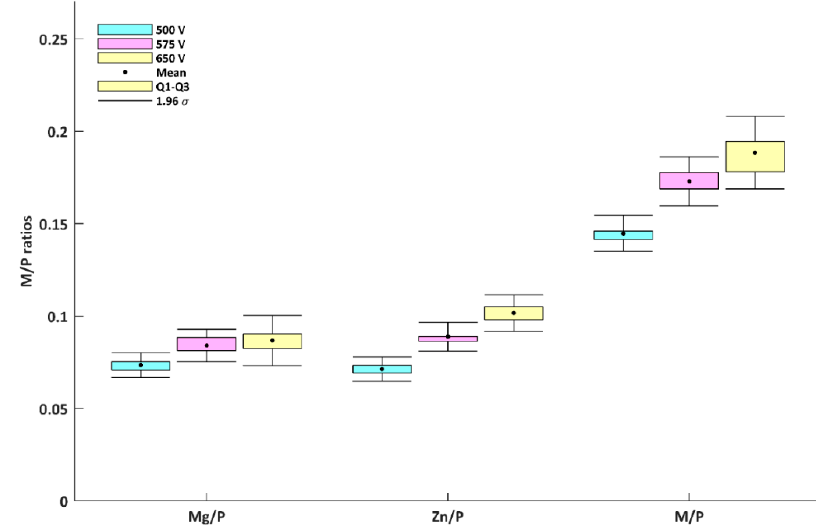
Figure 10. EDS results for samples after PEO processing obtained in electrolytes composed of 250 g/L Mg(NO 3 ) 2 ·6H 2 O and 250 g/L Zn(NO 3 ) 2 ·6H 2 O in H 3 PO 4 at three voltages, 500 V, 575 V, and 650 V. Table 5. Statistical description of Mg/P, Zn/P and M/P ratios based on atomic percent (M = Mg + Zn). Ratios Voltage Mean Stand. Dev.